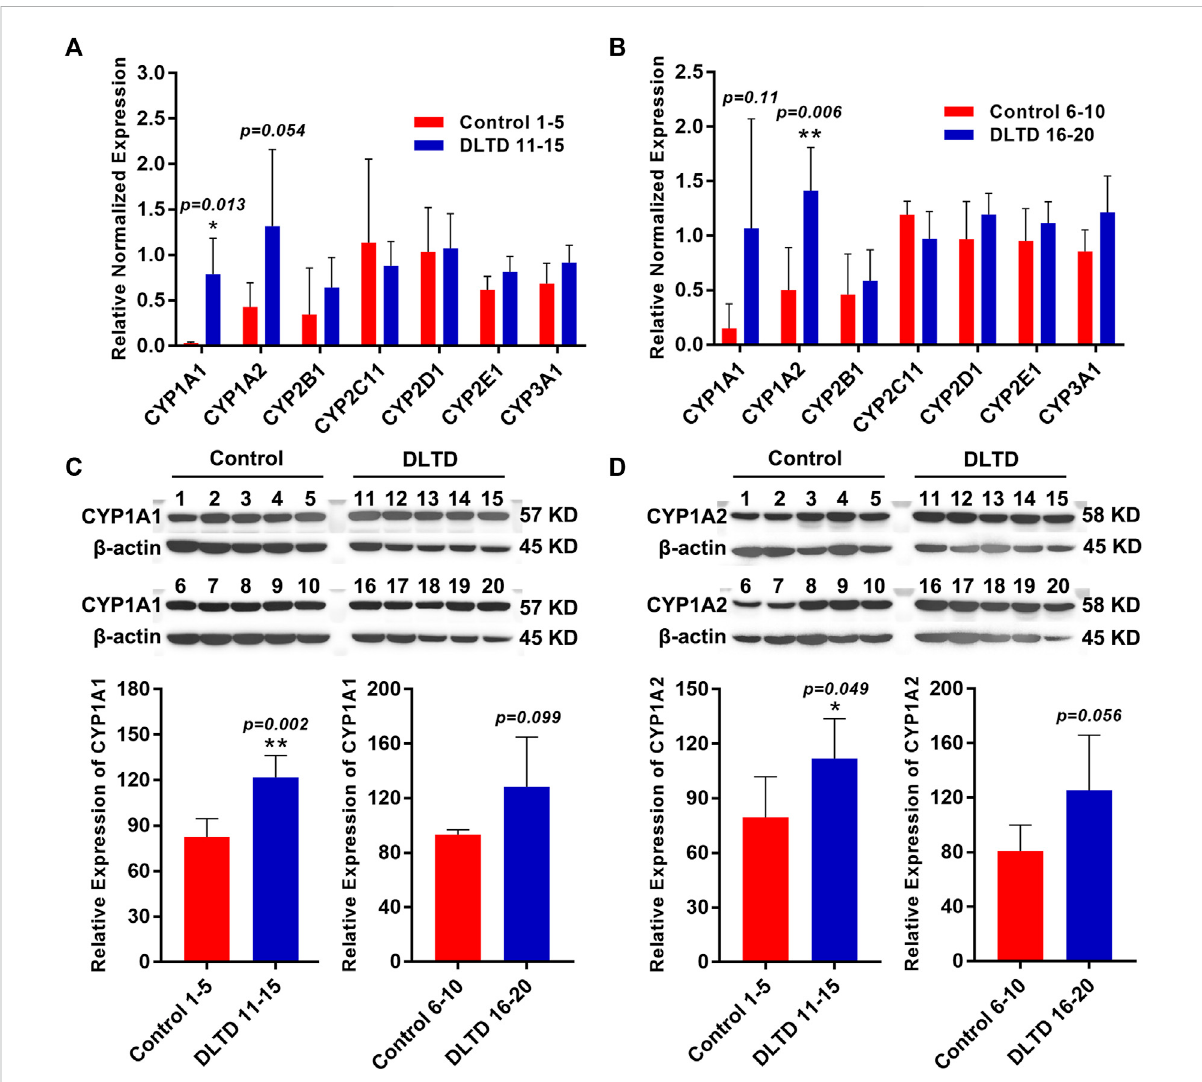
FIGURE 5 Validation the differential expression of CYP450 enzyme in the control group and DLTD group. (A) The mRNA expressions of CYP1A1, CYP1A2, CYP2B1,CYP2C11,CYP2D1,CYP2E1,CYP3A1wasdetectedinControl1 – 5andDLTD11 – 15byquantitativereal-timePCR. (B) ThemRNAexpressions of CYP1A1, CYP1A2, CYP2B1, CYP2C11, CYP2D1, CYP2E1, CYP3A1 was detected in Control 6 – 10 and DLTD 16 – 20 by quantitative real-time PCR. (C) The protein level of CYP1A1 was detected in Control 1 – 5 and DLTD 11 – 15 or in Control 6 – 10 and DLTD 16 – 20 by western blot. (D) The protein level of CYP1A2 was detected in Control 1 – 5 and DLTD 11 – 15 or in Control 6 – 10 and DLTD 16 – 20 by western blot. The statistical signi fi cance of differences was calculated by t -test. * p < 0.05, ** p < 0.01 versus the